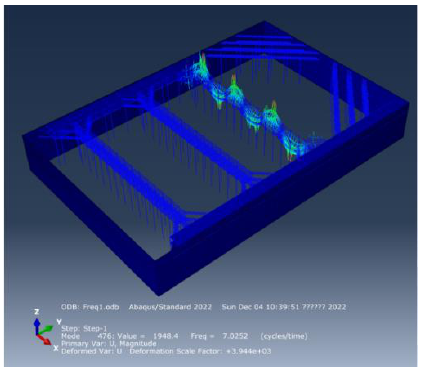
Figure 8. Vertical fourth-order vibration mode (7.02 Hz).